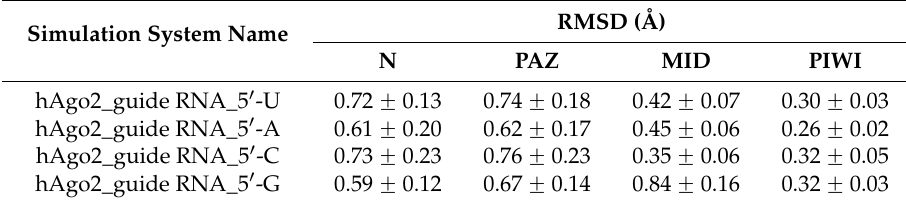
Table 2. Mean and standard deviation of the RMSD calculated for hAgo2 protein domains in the presence of different 5 1 -bases (U, A, C, and G). The RMSD were calculated from the 100 ns MD simulations after fitting on backbone atom of each domain